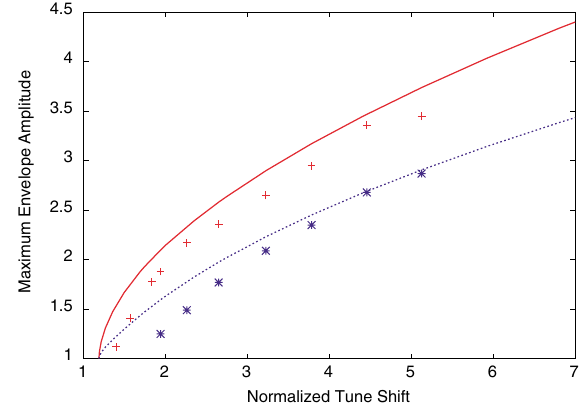
FIG. 1. (Color) Vertical beam envelope versus distance over one turn of a PSR phase-advance-equivalent uniform-focusing lattice. The envelope is normalized to the zero-space charge p (cid:12) envelope, (cid:1)(cid:1)(cid:1)(cid:1)(cid:1)(cid:1)(cid:1)(cid:1)(cid:1)(cid:1)(cid:1) (cid:11) y y